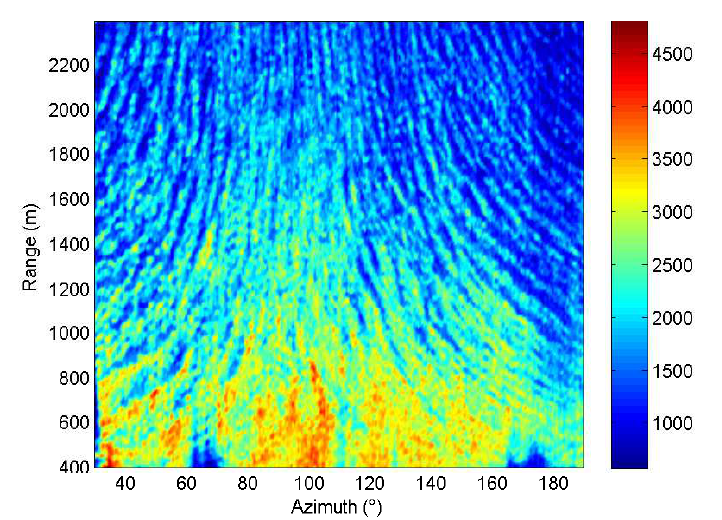
Figure 4. The radar image after sparse